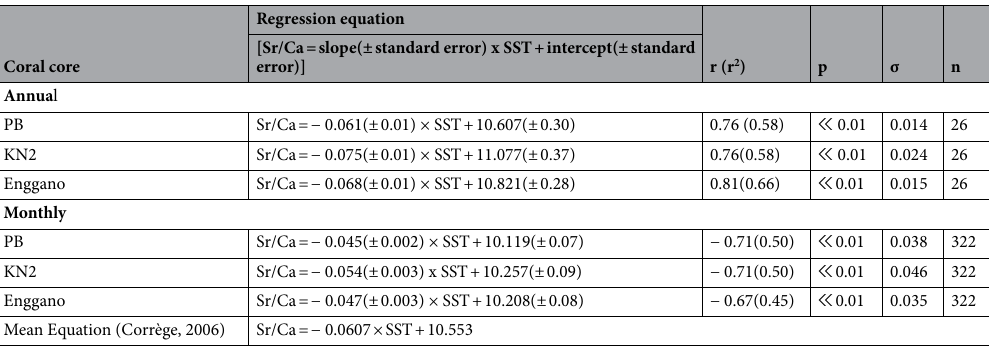
Table 1. Linear regression equation and correlation coefficient between annual mean and monthly coral Sr/Ca and NOAA OISSTv2 centered at Enggano Island (5°S, 102°E) for the time period 1982–2008 and the mean equation from 17 for comparison. r(r 2 ) is the correlation coefficient, p is the p-value and σ is the standard deviation of the